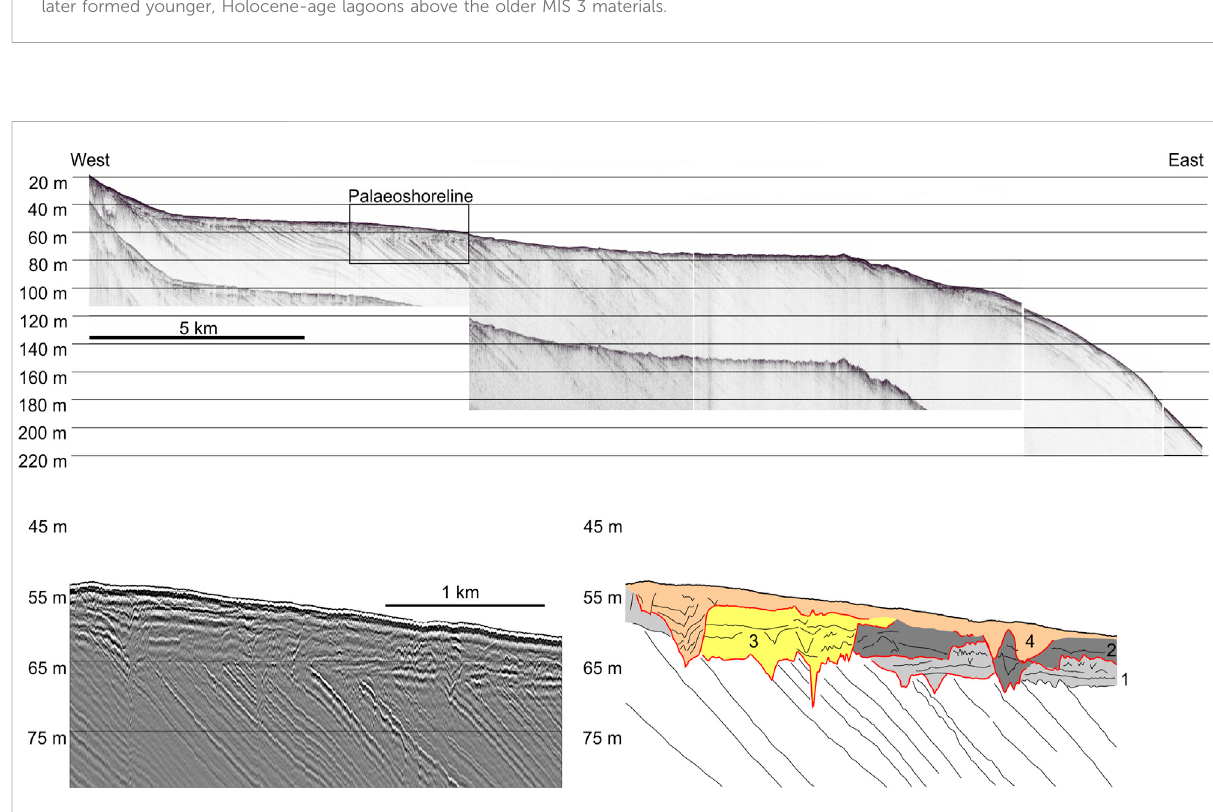
FIGURE 9 Seismic re fl ection pro fi le offshore Sibhudu Cave. The below interpretation highlights at least four phases of channel incision and lagoon development behind an aeolianite to seaward, spanning a possible MIS 12 to MIS 2 age